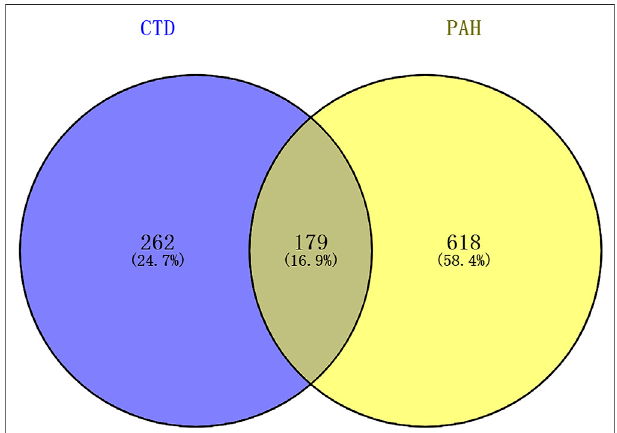
FIGURE 2 | The results of text mining. A total of 797 genes were related to PAH, 441 genes were related to CTD, and 179 genes overlapped between PAH and CTD. PAH, pulmonary arterial hypertension; CTD, connective tissue diseases.